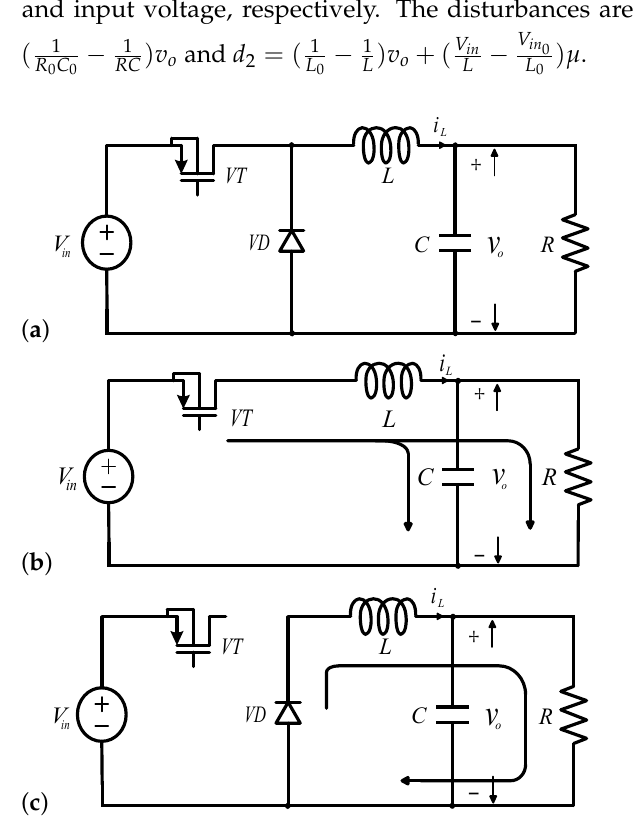
Figure 1. Circuit diagram of buck converter. ( a ) An average case. ( b ) A switch ON case. ( c ) A switch OFF